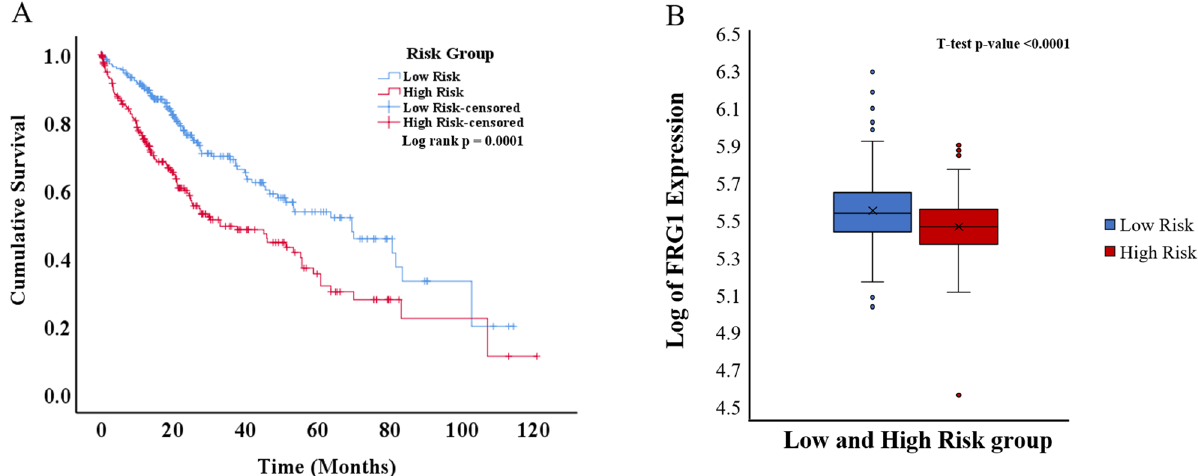
Figure 6. Kaplan–Meier plot and box plot of liver cancer patients risk groups based on the multigene model. ( A ) KM plot showing overall survival in low-risk and high-risk patient groups (Log-rank test p-value = 0.0001). The blue line shows the low-risk group, and the red line shows the high-risk group. ( B ) Box plot showing the log of FRG1 expression level in low and high-risk groups. The Y-axis represents the log of FRG1 expression, and the X-axis shows the